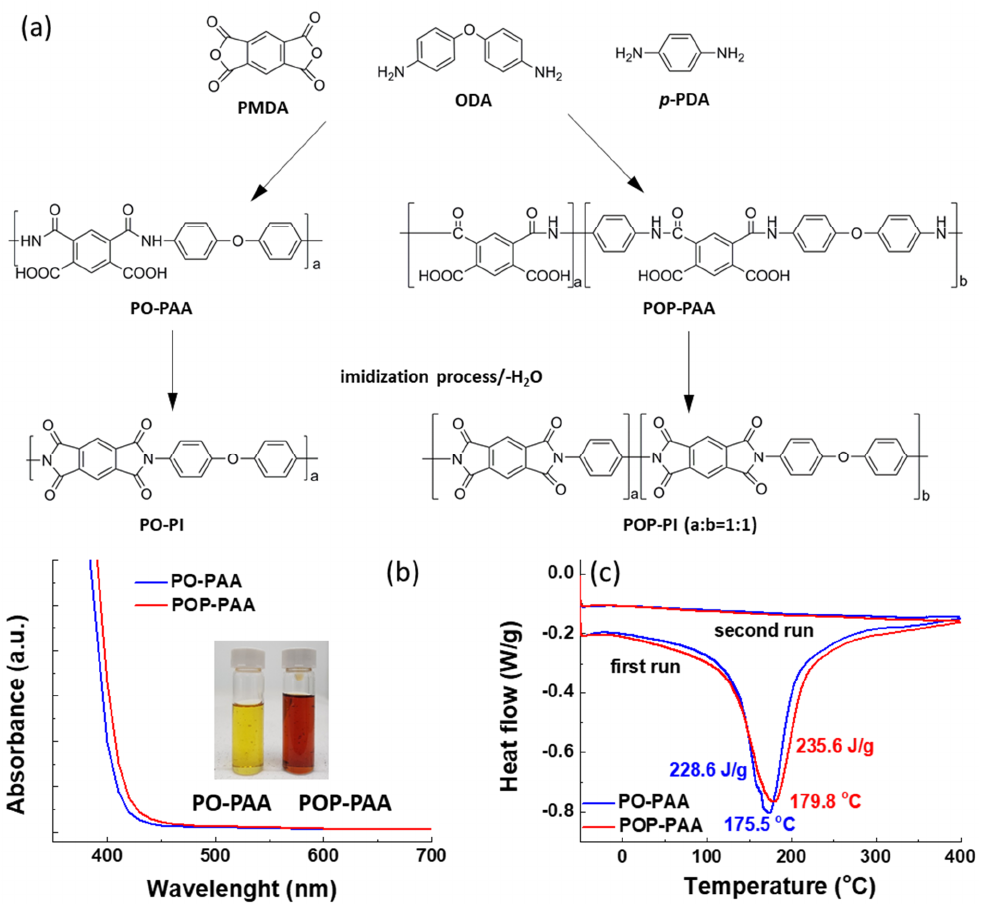
Figure 1. ( a ) The process of preparation of PMDA (pyromellitic dianhydride) and ODA (4,4′-oxydianiline) (PO-) and PMDA/ODA/ p -phenylenediamine ( p -PDA) polyimide (POP-PI) with PMDA, ODA, and p -PDA; ( b ) the absorbance spectrum of PO- and POP-PAA solution and ( c ) the differential scanning calorimetry (DSC) profile of the PO- and POP-PAA (poly(amic acid)).